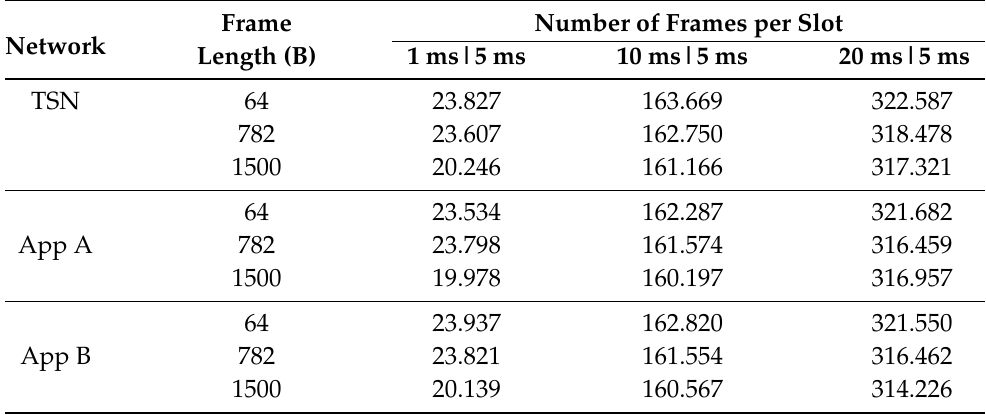
Table 6. Mean number of number of frames that the network can effectively exchange within a slot using TSN, approach A and approach B, with different slot sizes and frame